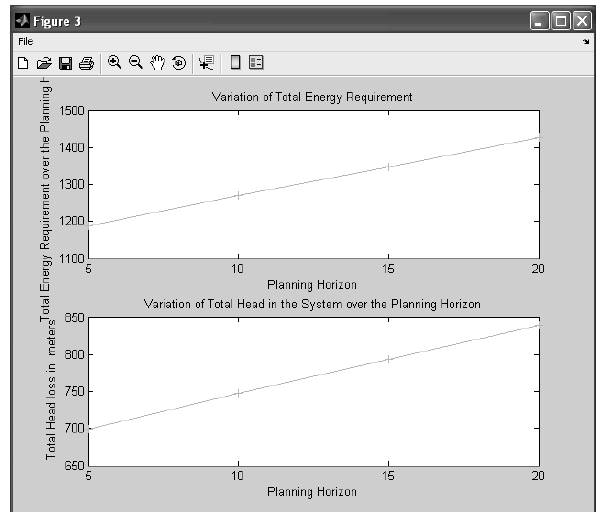
Fig. 17. Variation of Hazen-William C-values for different groups